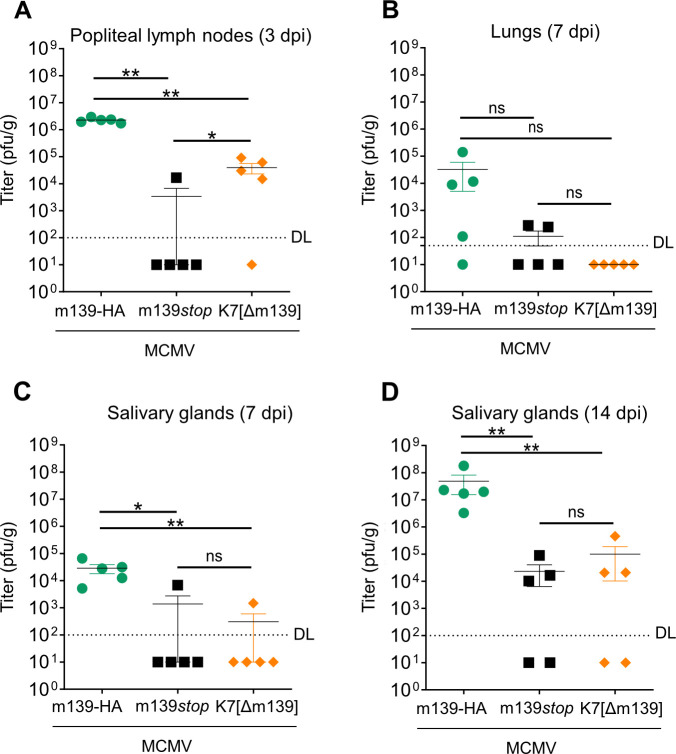
m139 is crucial for MCMV dissemination.BALB/c mice were infected by injection of 105 PFU MCMV m139-HA, m139stop, or K7[Δm139] into the footpad. Mice (5 per group) were sacrificed on days 3, 7, and 14 post infection, and MCMV titers in different organs were determined by plaque assay. Titers in (A) popliteal lymph on day 3, (B) lungs on day 7, and salivary glands on day7 (C) and 14 (D) post infection are shown as mean titers ±SEM. DL, detection limit; ns, not significant; *, p<0.05; **, p<0.01.